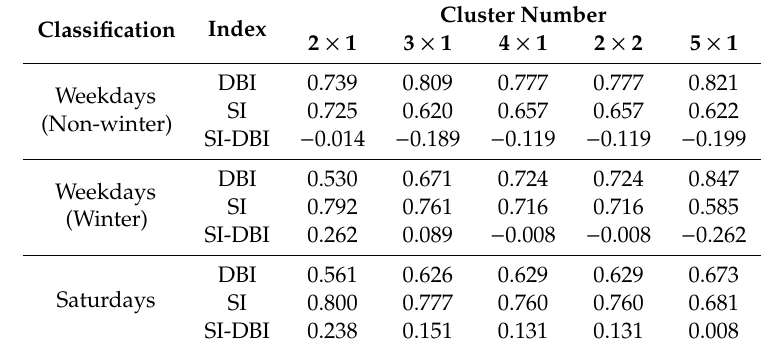
Table 6. Internal evaluation indices at di ff erent cluster numbers based on the SOM.